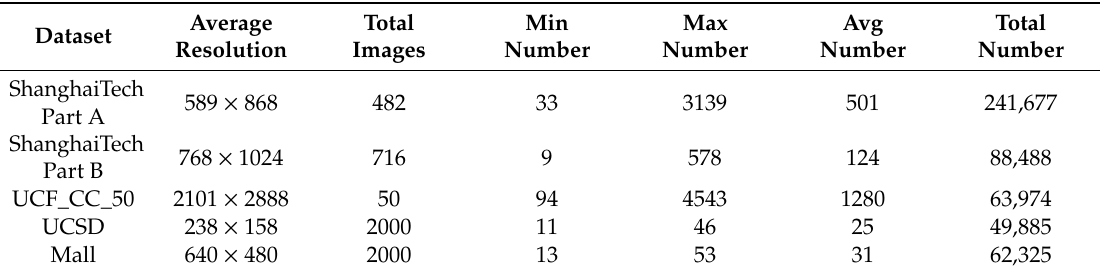
Table 1. Di ff erent dataset